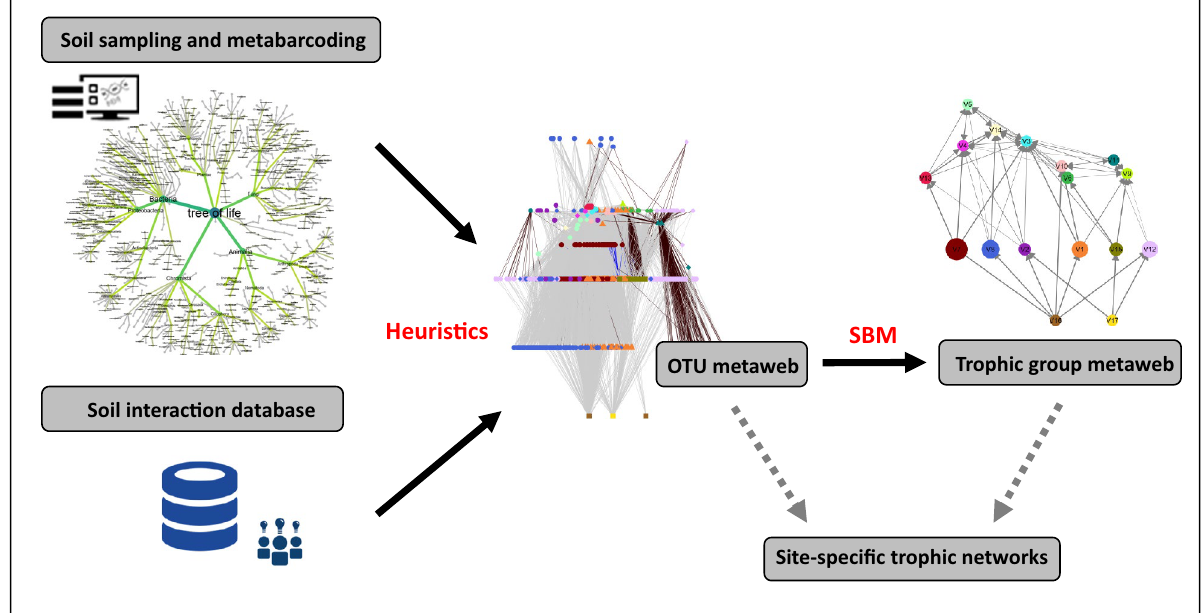
Figure 1. Inference of trophic network structure for the present study using Next ‐ Generation Sequencing technologies and a database of ecological